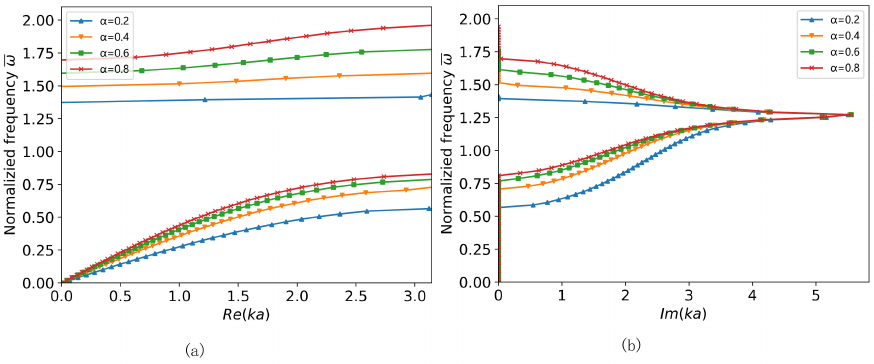
Figure 5. Dispersion relation for the nonlinear Ems with β = 2, γ A 1, n A 1, n = 0.2 and different mass